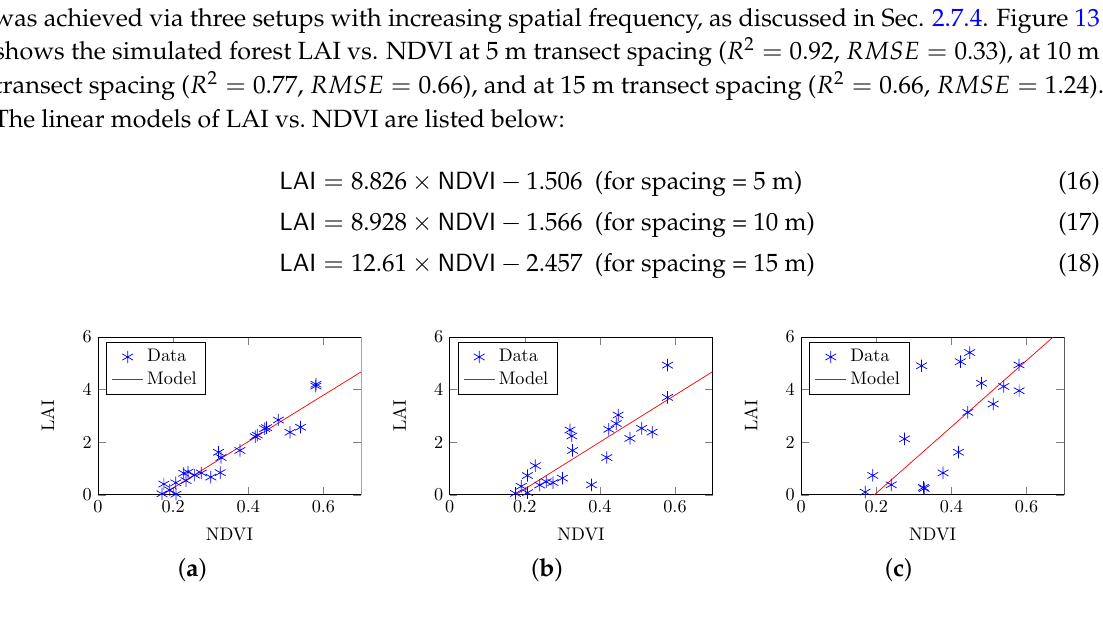
Figure 13. Leaf area index (LAI) estimates derived from simulated AccuPAR readings against the normalized difference vegetation index (NDVI) extracted from simulated Airborne Visible/Infrared Imaging Spectrometer (AVIRIS) images. ( a ) 45 PAR readings were simulated along three transects in each 15m × 15m square ( R 2 = 0.92, RMSE = 0.33); ( b ) 30 PAR readings were simulated along two transects in each 15m × 15m square ( R 2 = 0.77, RMSE = 0.66); and ( c ) 15 PAR readings were simulated along one transect in each 15m × 15m square ( R 2 = 0.66, RMSE =